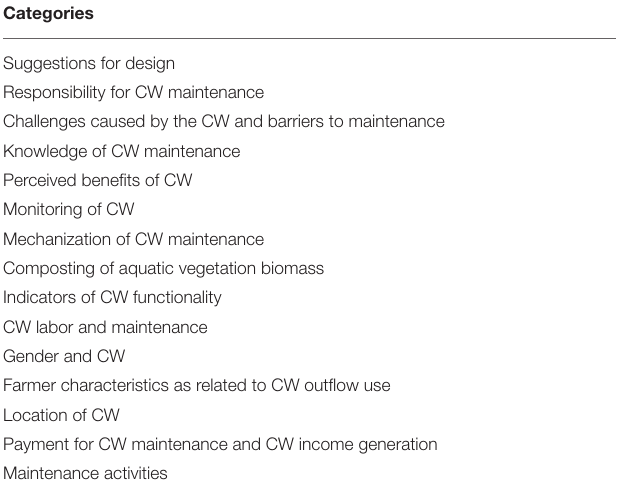
TABLE 3 | Code book for data analysis. TABLE 4 | Codebook example of themes grouped under the category of CW labor and